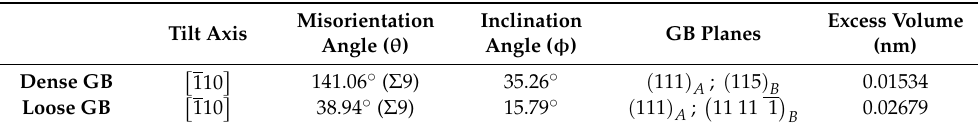
Figure 6. Relaxed GB structures and misalignments of the slip systems across neighboring grains. ( a ) and ( c ): Cu bicrystal with the dense boundary; ( b ) and ( d ): Cu bicrystal with the loose boundary. Atomic snapshots are taken along the (cid:4670)11(cid:3364)1(cid:4671) tilt axis (points out of the paper). Atoms are colored according to the centrosymmetry parameter. The blue end of the color bar corresponds to zero, while the red end of the color bar corresponds to ten.